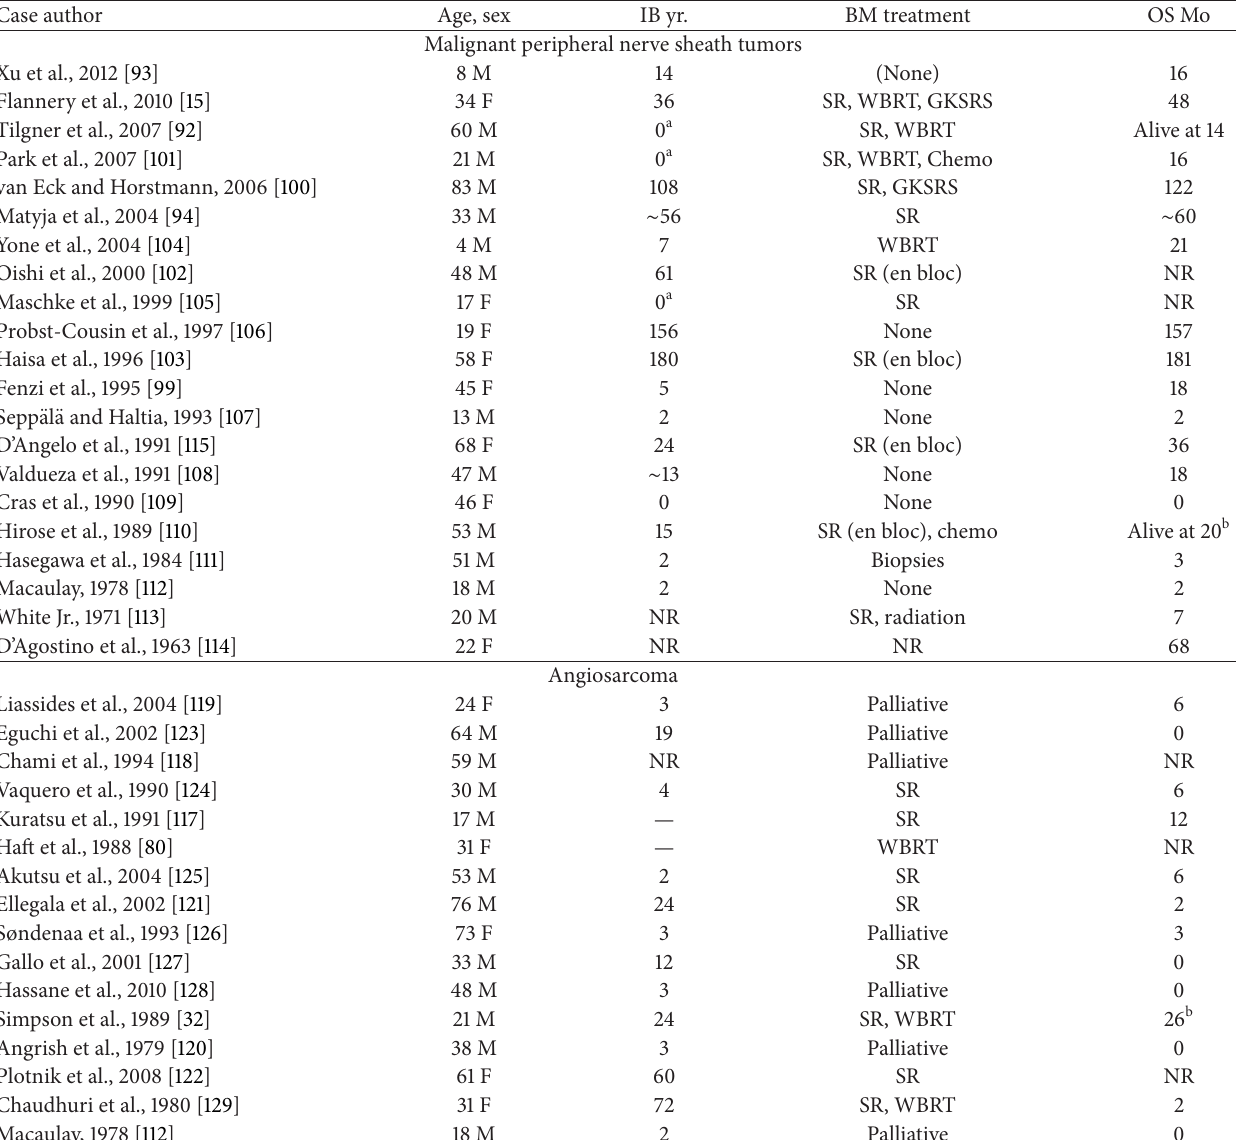
Table 6: Comparison of published reports detailing characteristics of patients with brain metastases from malignant peripheral nerve sheath tumor (MPNST) and